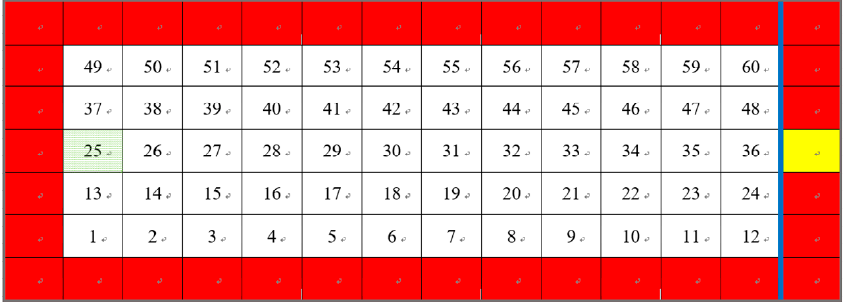
Figure 17. State of the Q-learning algorithm by transforming the coordinates in the training field.